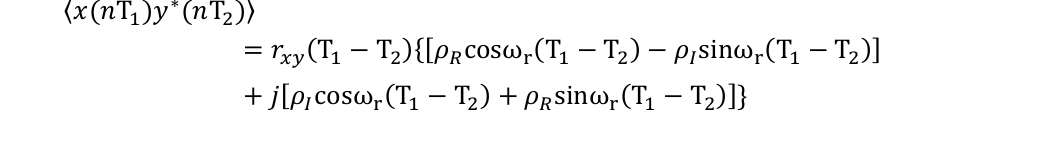
is the sampling skew